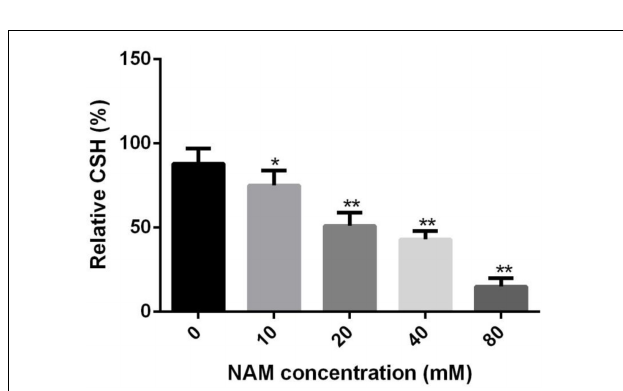
FIGURE 5 | Effects of NAM on the cell surface hydrophobicity (CSH). C. albicans cells were treated with different concentrations of NAM for 16 h and then CSH was estimated by the water-hydrocarbon two-phase assay. Data are expressed as the mean ± standard deviation of the independent assays in triplicate. ∗ P < 0.05; ∗∗ P < 0.01 as compared to the NAM-free